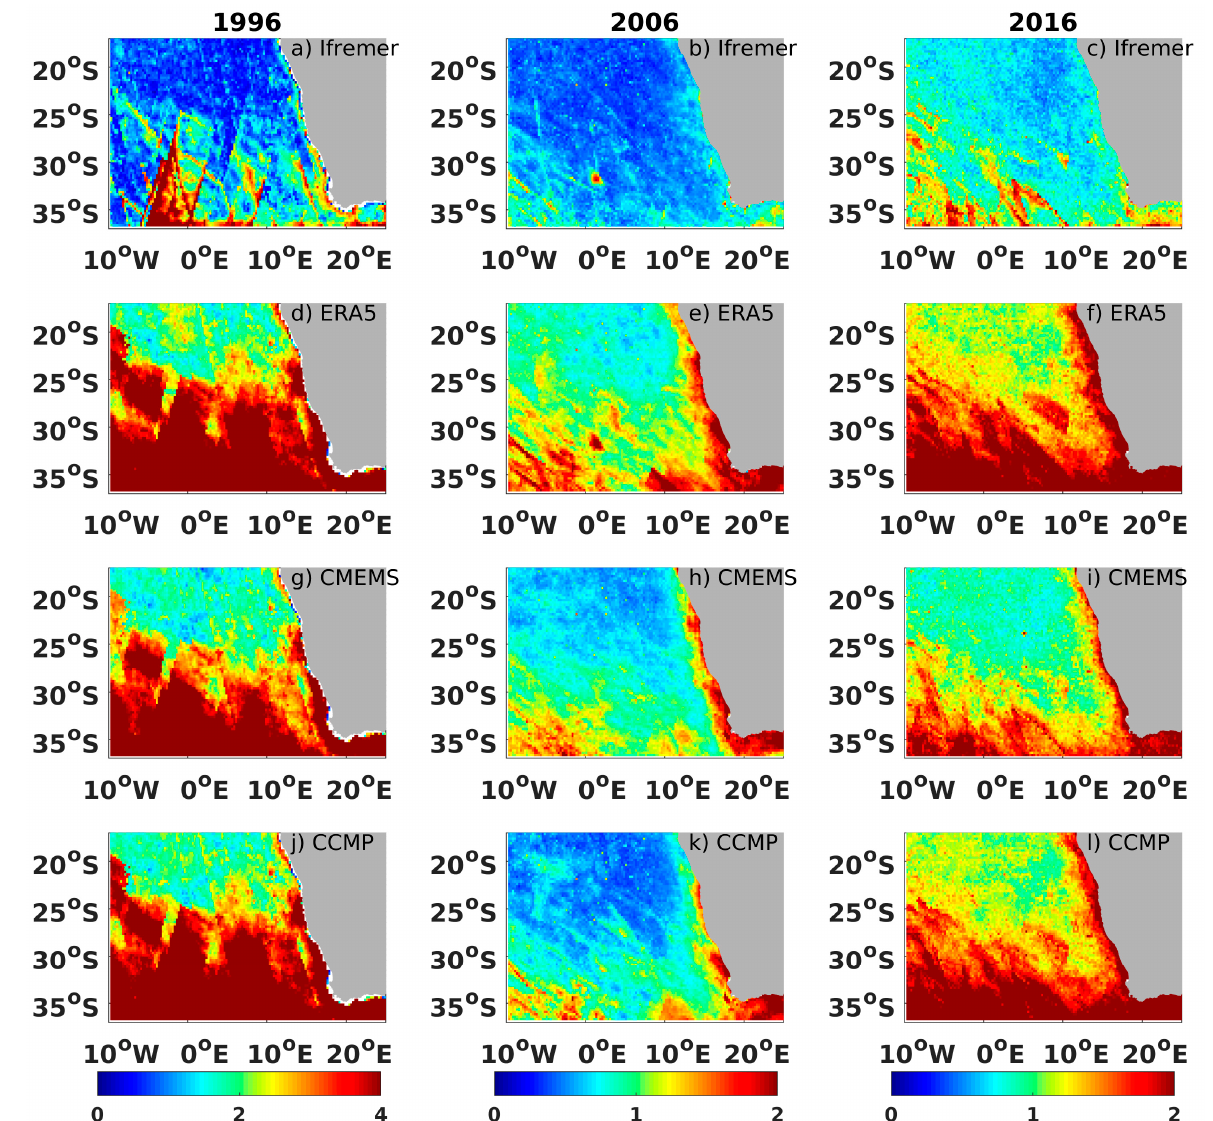
Figure A7. Spatial distributions of root mean square of meridional wind component differences between collocated scatterometer retrievals and satellite wind analyses, referenced as Ifremer, ( a – c ), ERA5 wind estimates ( d – f ), CMEMS winds ( g – i ), and CCMP winds ( j – l ). The results are drawn from data occurring, over the Benguela zone, in 1996 (panels in left column), 2006 (middle column), and 2016 (right column). Color indicates RMSD values in m/s. One should notice that the color bar associated with 1996 is different from the 2006 and 2016 ones.